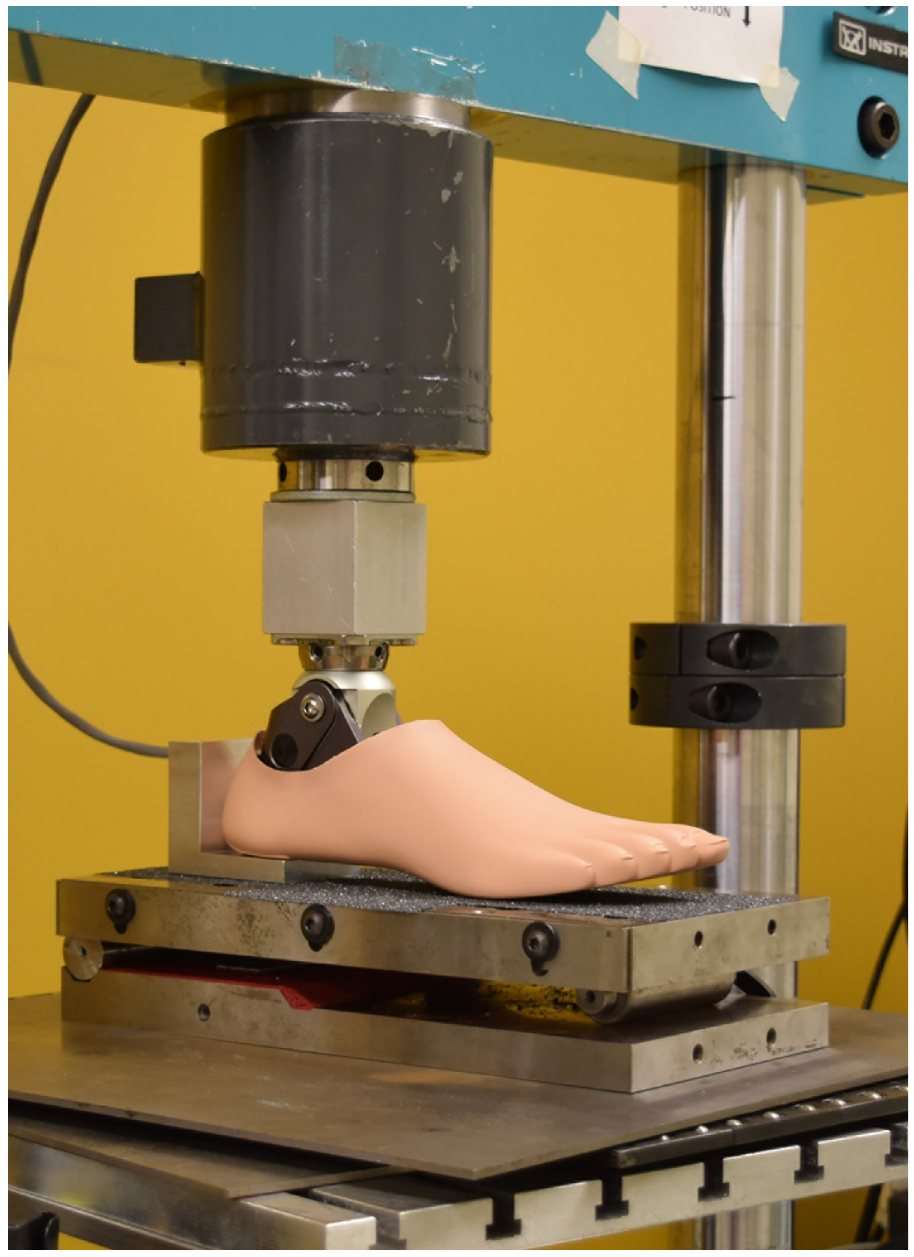
Fig 3. Test set up for the barefoot midstance condition, including the heel